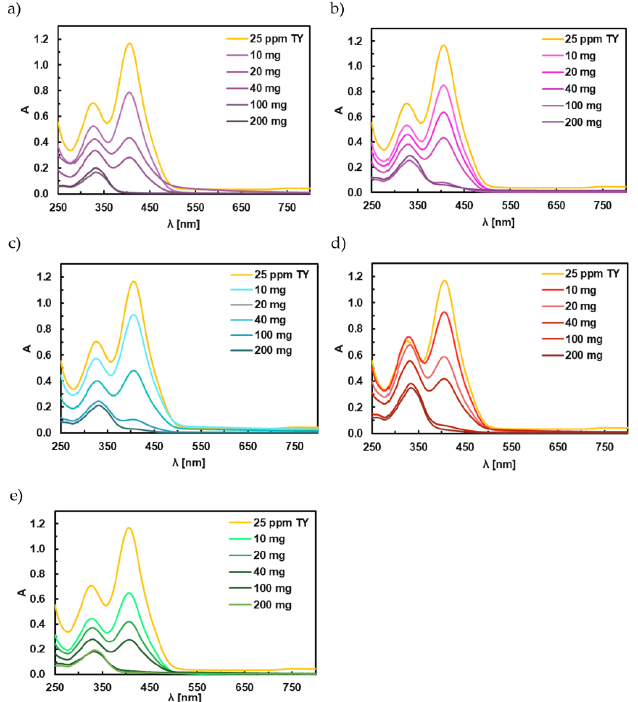
Figure 6. Survey UV-vis spectra adsorption of Titan yellow dye by ( a ) Fe 3 O 4 , ( b ) Fe 3 O 4 @1%Zn, ( c ) Fe 3 O 4 @2%Zn, ( d ) Fe 3 O 4 @5%Zn, and ( e ) Fe 3 O 4 @10%Zn nanoparticles in different mass ratios after 30 min in pH